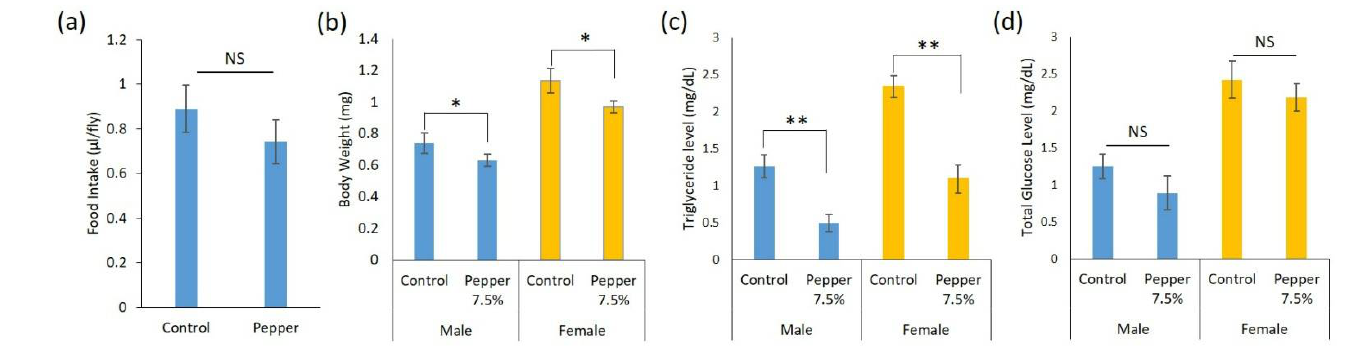
Figure 1. Food intake and physiological changes of Drosophila melanogaster in response to control and pepper diet. ( a ) Food consumption ( µ L/fly) ( b ) body weight determination ( c ) triglycerides content and ( d ) glucose level under control and habanero-pepper diets. Data are mean ± SEM for n = 10 independent replicates. *, p ≤ 0.05, **, p ≤ 0.01, NS, not significant, compared to control treatment.